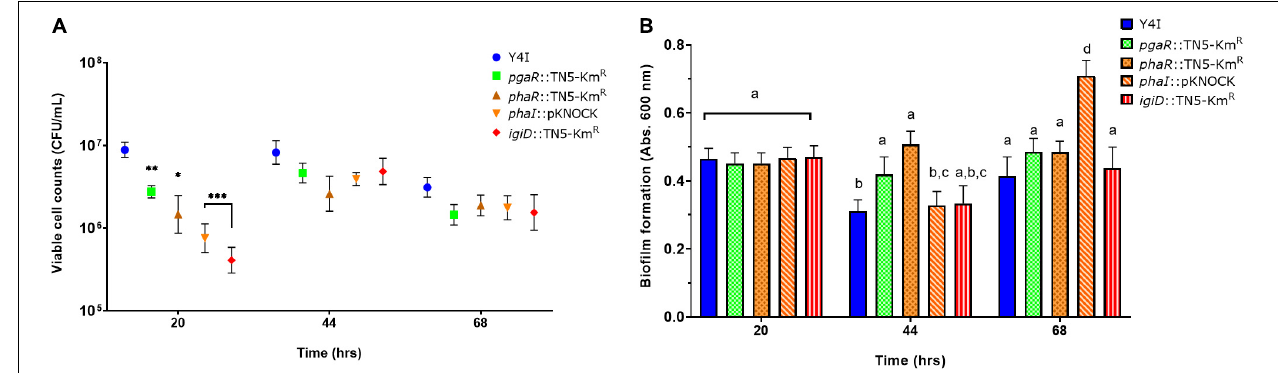
FIGURE 3 | Surface colonization and biofilm production over time in Y4I mutant variants. Viable cell counts of surface attached cultures in Y4I variants (A) . Each data point represents the average of three biological and three technical replicates. Data was normalized to cell abundance in liquid culture at the time of inoculation. Error bars represent the standard error of the mean of biological and technical triplicates. The asterisks denote statistical significance from WT at that time point [ P < 0.05 (*), 0.01 (**), 0.001 (***)]. Total biofilm of surface attached cultures in Y4I variants as determined by crystal violet assay (B) . Data is representative of the mean of three biological and three technical replicates. Letters that are not shared represent significant difference ( p < 0.05). Error bars represent the standard deviation from the mean.